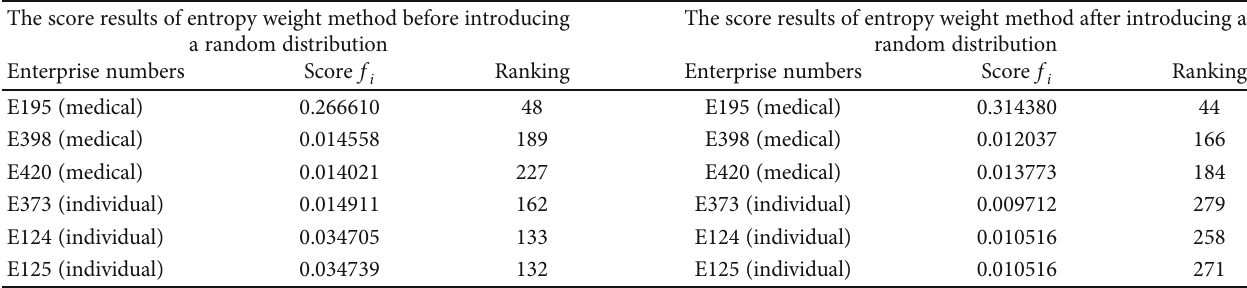
Table 4: Changes in medical and individual business scores and rankings after the introduction of random distribution. The score results of entropy weight method before introducing